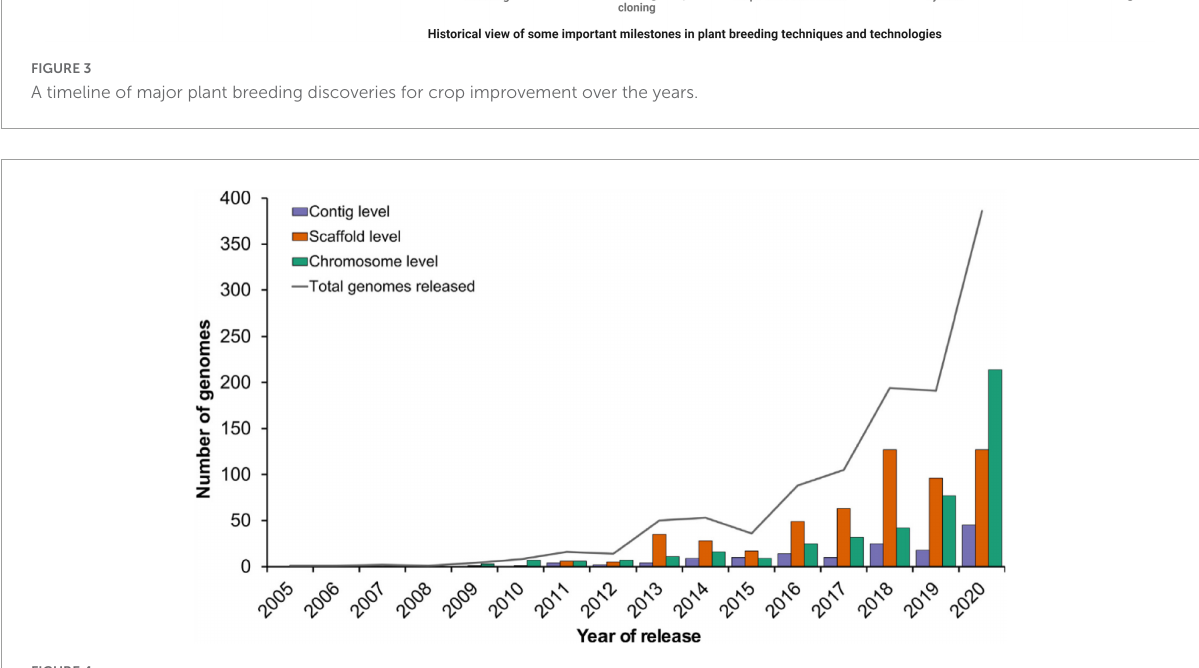
FIGURE4 Recent trends in plant genome sequencing (Varshney et al.,